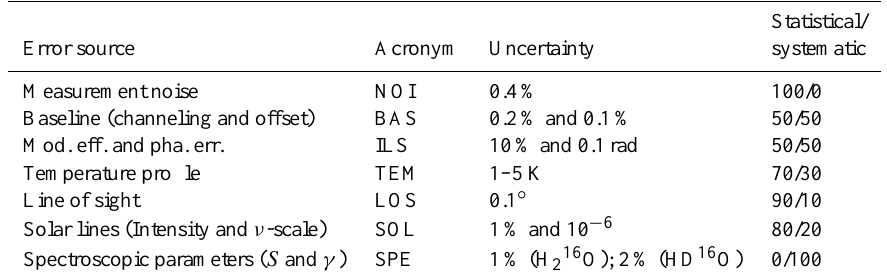
Table 2. Experimental and temperature uncertainty sources used for our error estimation. The third column gives the uncertainty value and the fourth column the partitioning between statistical and systematic sources.